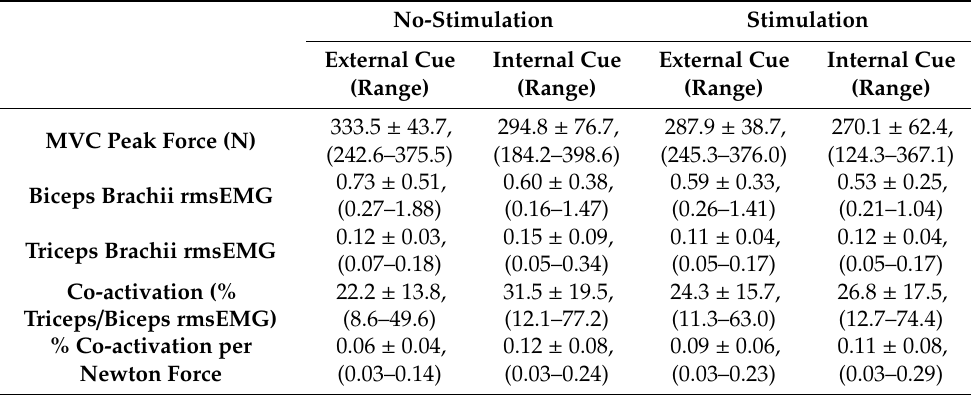
Table 1. Mean ± SD of MVC force and electromyographic (EMG) data, collapsed across trials (trial 1 to trial 6), presented for conditions (external cue, internal cue) during both no-stimulation and stimulation sessions.